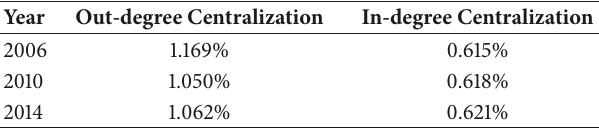
Table 5: Statistical table of the urban network centralization of the HRB.